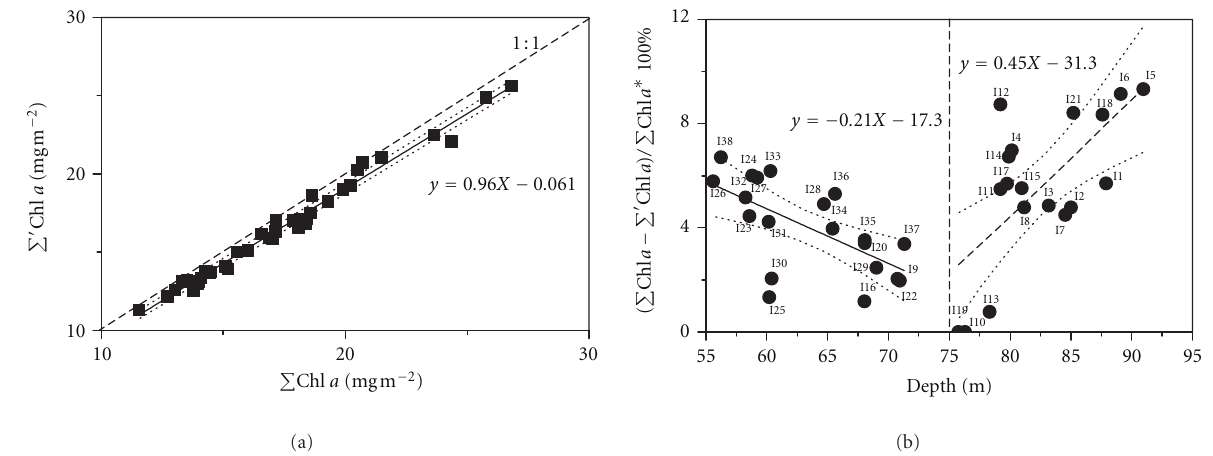
(cid:2) (cid:3) Chl a , mgm − 2 ) not including the real DCM as a function of that including it ( Figure 4: (a) Integrated Chl a ( line showing the significant relationships ( r = 0 . 99, P < 0 . 01, n = 38). (b) The underestimated function of its depth (m), with the lines indicating the significant relationship (solid line, r = − 0 . 63, P < 0 . 05, n = 20; dashed line, r = 0 . 68, P < 0 . 01, n = 18).